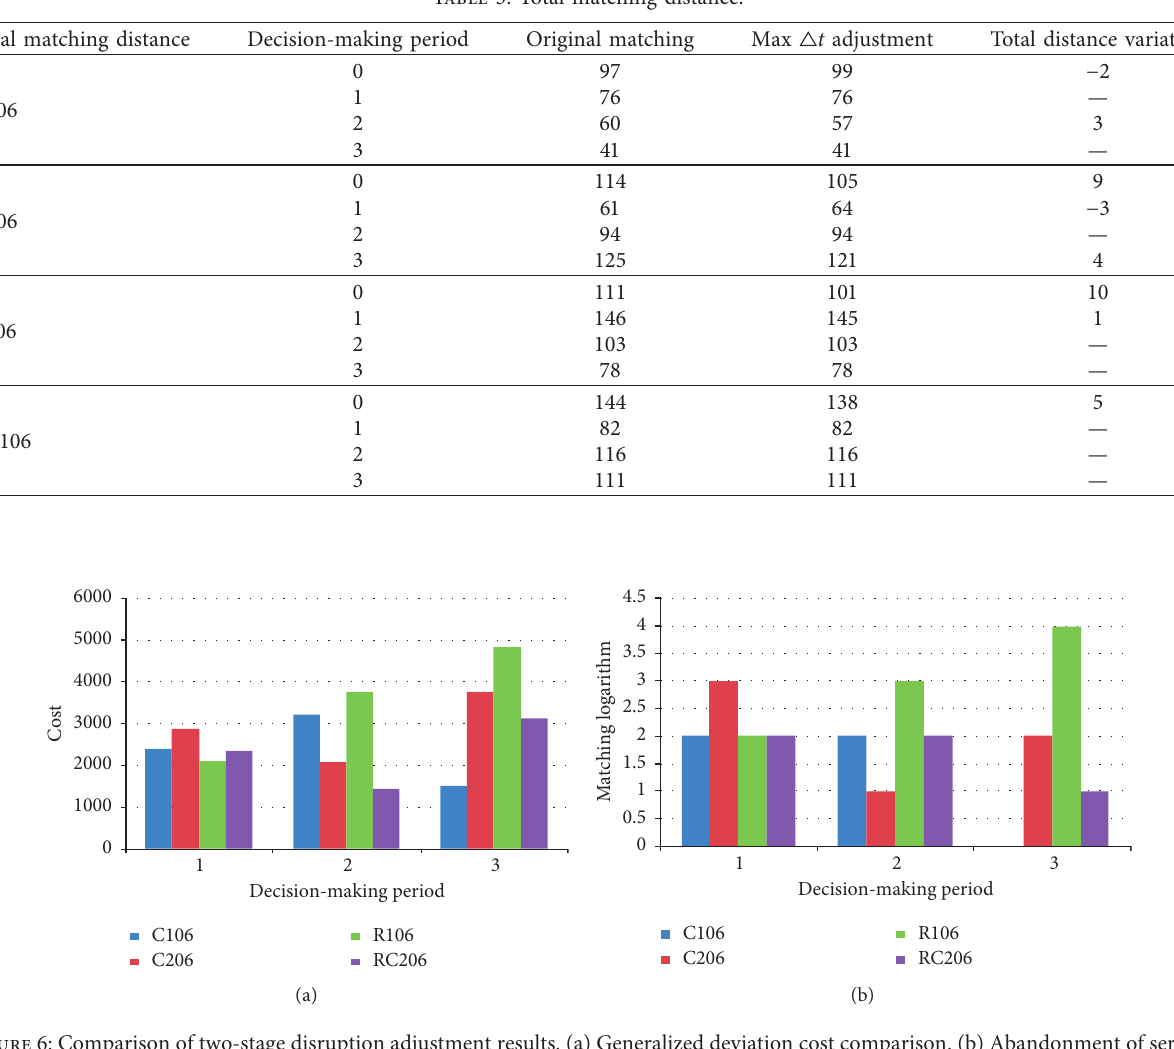
Table 3: Total matching